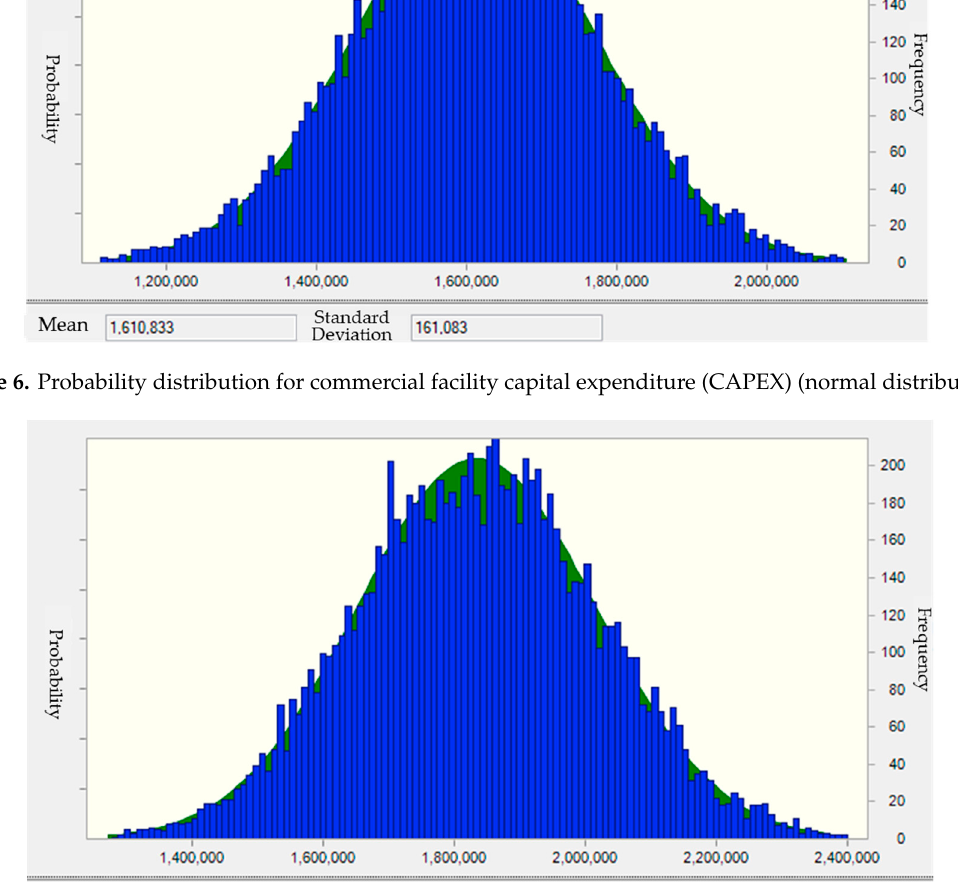
Figure 8. System degradation rate probability distribution (triangular distribution). 4.1.6. Corporate Tax Corporate tax is a policy variable, and the following scenario was proposed as a hypothesis. The corporate tax will decline from its current state until it reaches a range where all corporate tax is exempt. The probability distribution suited to this hypothesis is the triangular distribution, which can arbitrarily establish a threshold. This study assumes the triangular distribution, while the mode and maximum value were set at the current level of corporate tax at 24.2% (including residence tax), with the minimum value set at 0% (exemption of corporate tax scenario). Finally, as per Figure 9, a right triangle distribution was generated where the probability reaches its highest point at 24.2% and then declines gradually.